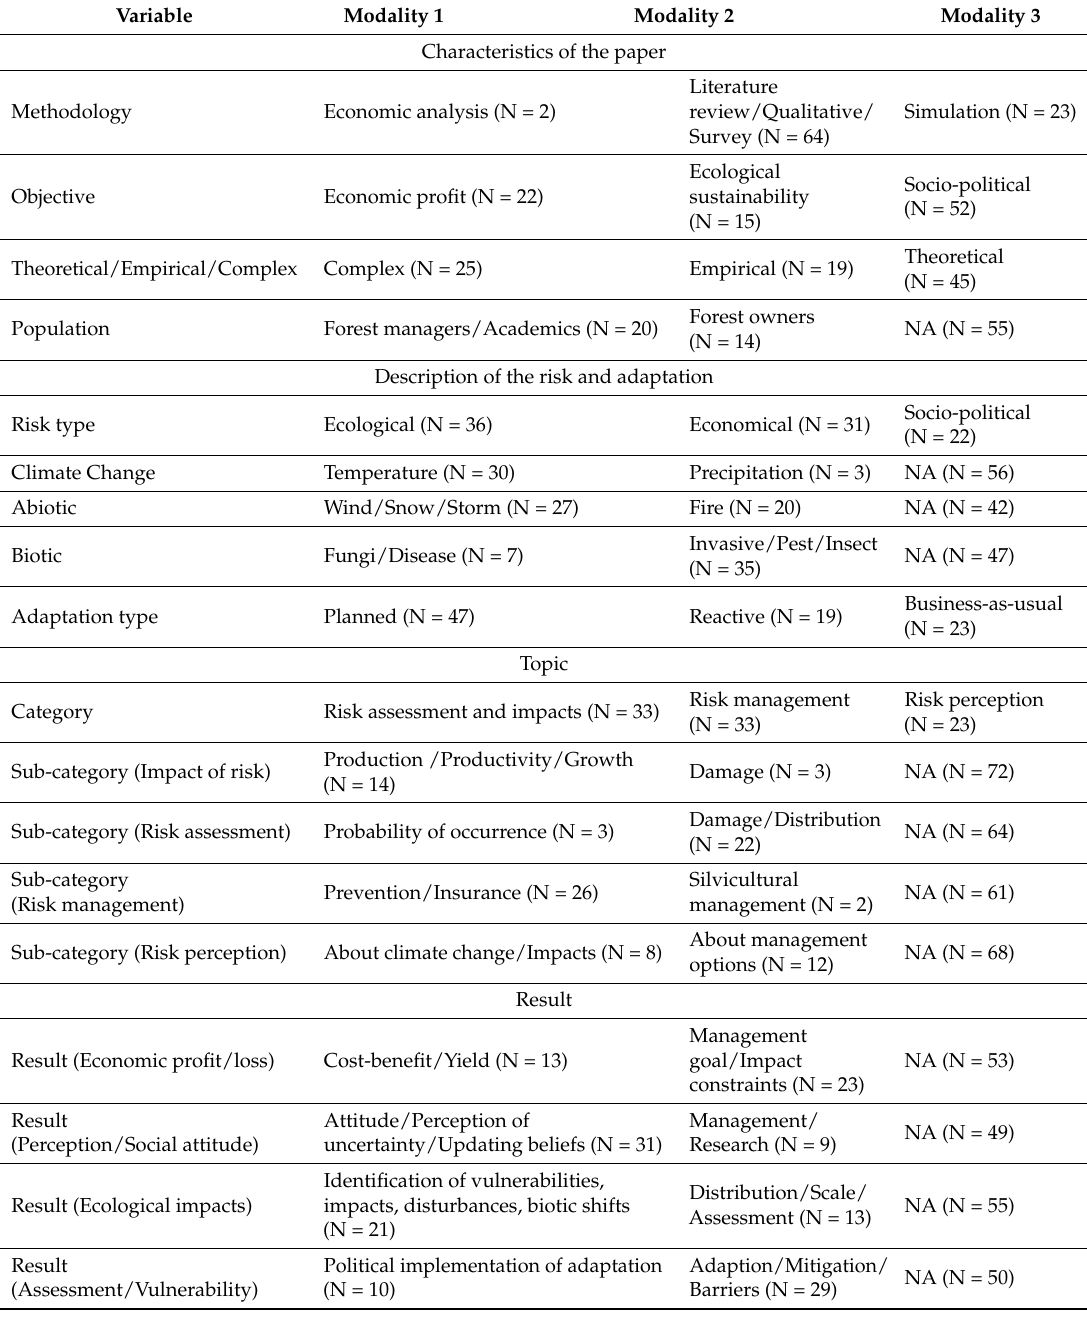
Table A3. List of variables and modalities, and associated frequencies (N) in the